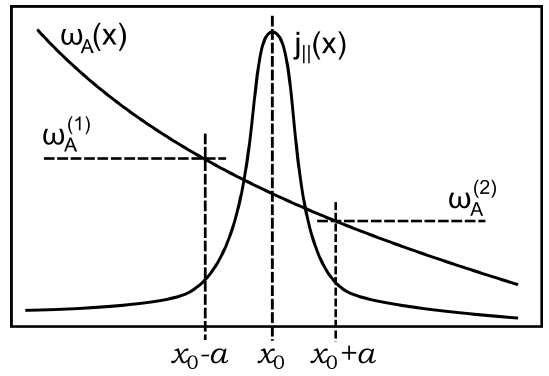
Figure 1. Range of the resonant frequencies determined by FAC